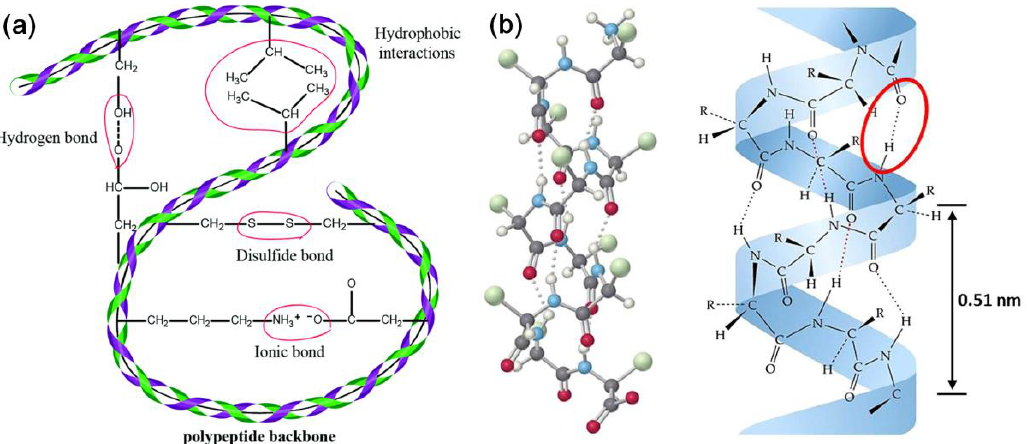
Figure 5. Schematic illustrations of the ( a ) intermolecular bonding and ( b ) intermediate filament structure of α -keratin. Reproduced ( a ) from [113], with permission from Royal Society of Chemistry, 2017. And ( b ) from [114], with permission from Elsevier, 2016.